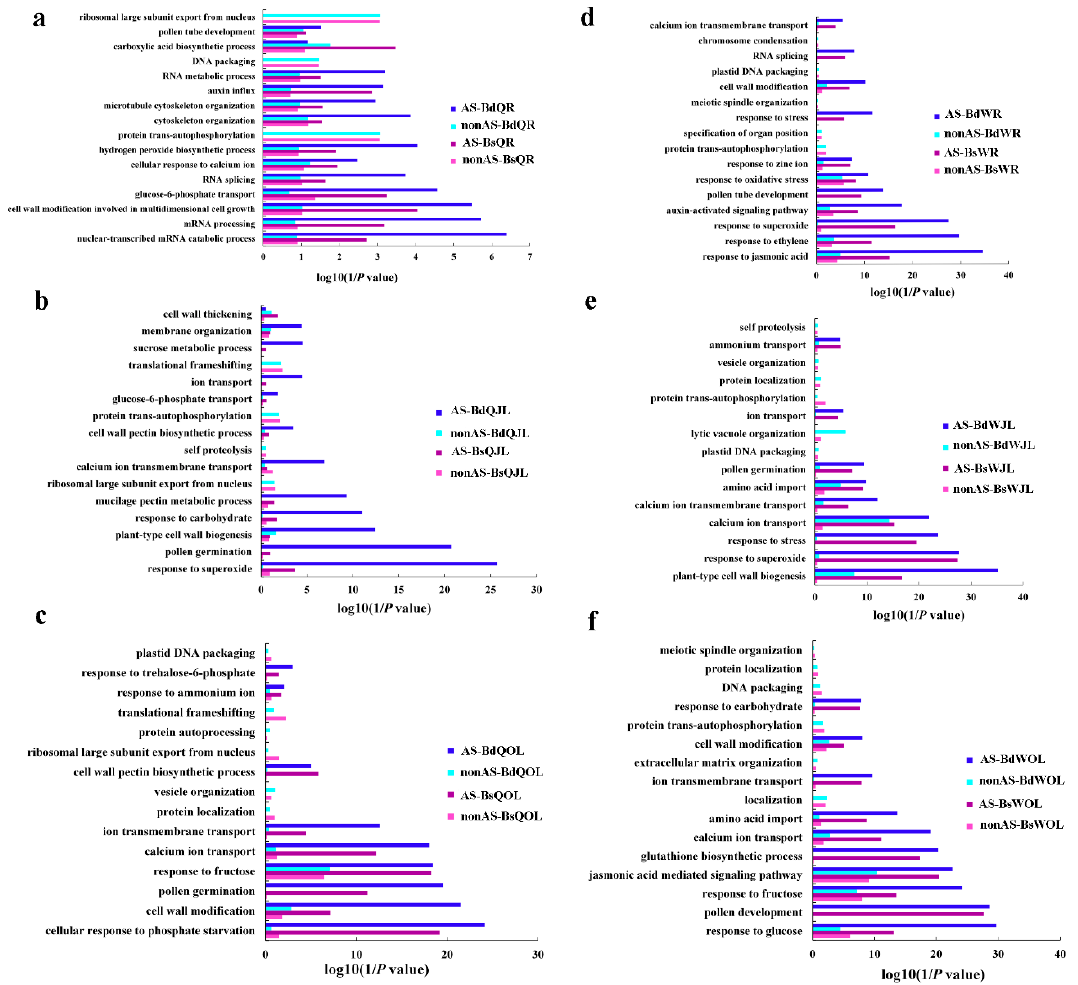
Figure 7. GO terms of the functional categorization of AS and non-alternative splicing (nonAS) genes (biological process) in the root, juvenile leaves and old leaves of B. napus cultivars Qingyou10 (QY10) and Westar10 (W10) under boron (B) sufficient and deficient conditions: ( a ) root of QY10; ( b ) juvenile leaves of QY10; ( c ) old leaves of QY10; ( d ) root of W10; ( e ) juvenile leaves of W10; and ( f ) old leaves of W10. AS, alternative splicing; nonAS, non-alternative splicing; Bs, B sufficient condition; Bd, B deficient condition; QR, root of QY10; QOL, old leaves of QY10; QJL, juvenile leaves of QY10; WR, root of W10; WOL, old leaves of W10; WJL, juvenile leaves of W10.